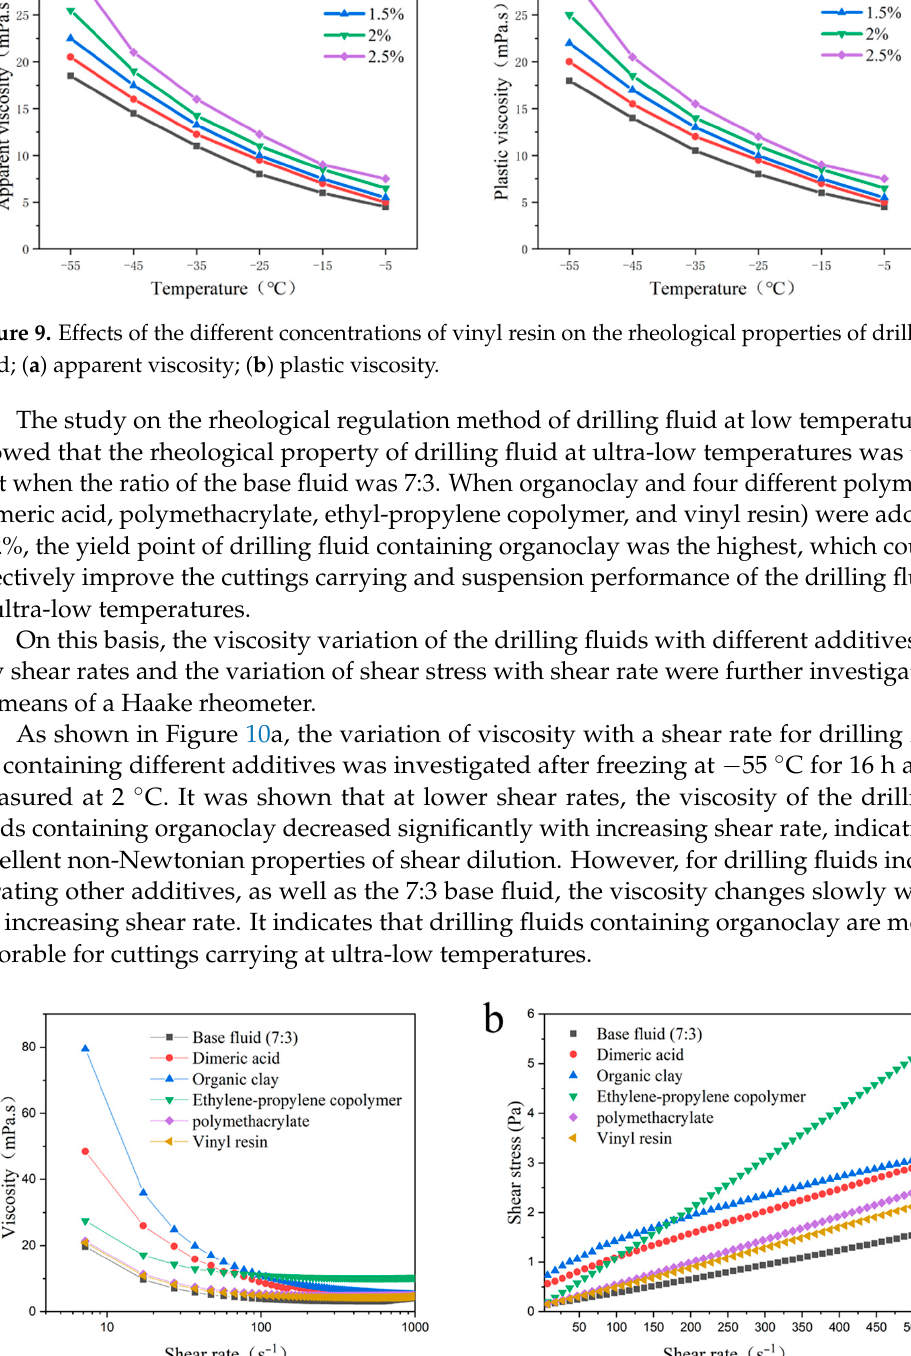
10 of 17 Figure 8. Effects of the different concentrations of ethylene propylene copolymer on the rheological properties of drilling fluid; ( a ) apparent viscosity; ( b ) plastic viscosity; ( c ) yield point. 4. Vinyl Resin The effects of different concentrations of vinyl resin (0.5%, 1%, 1.5%, 2%, 2.5%) on the apparent viscosity and plastic viscosity of drilling fluid at specific temperatures and the relationship between the viscosity of drilling fluid and temperature at specific additions